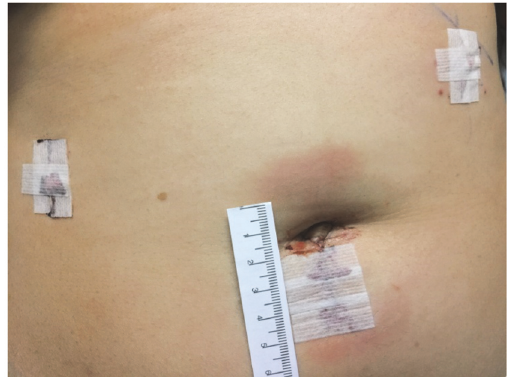
Figure 1: One 3 cm mini-laparotomic incision was made to hand- morcellate the large